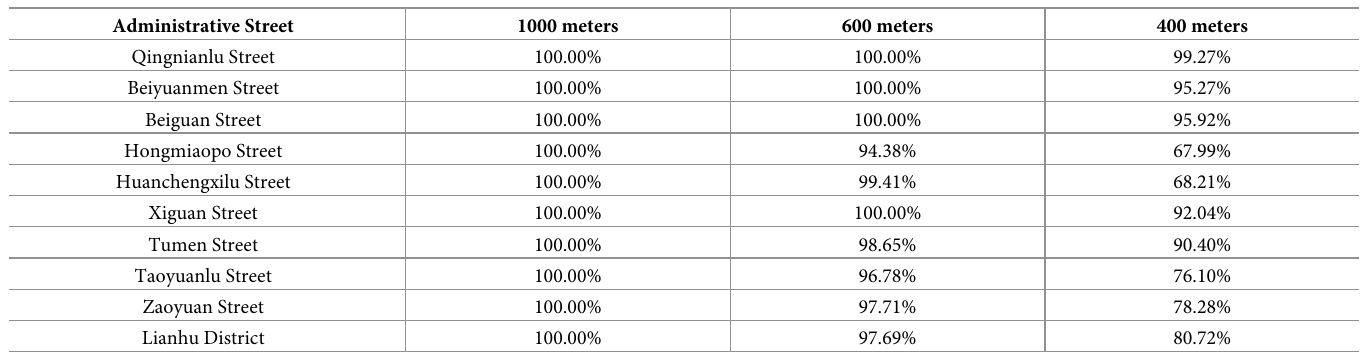
Table 3. Coverage rate of community home care facilities in Lianhu